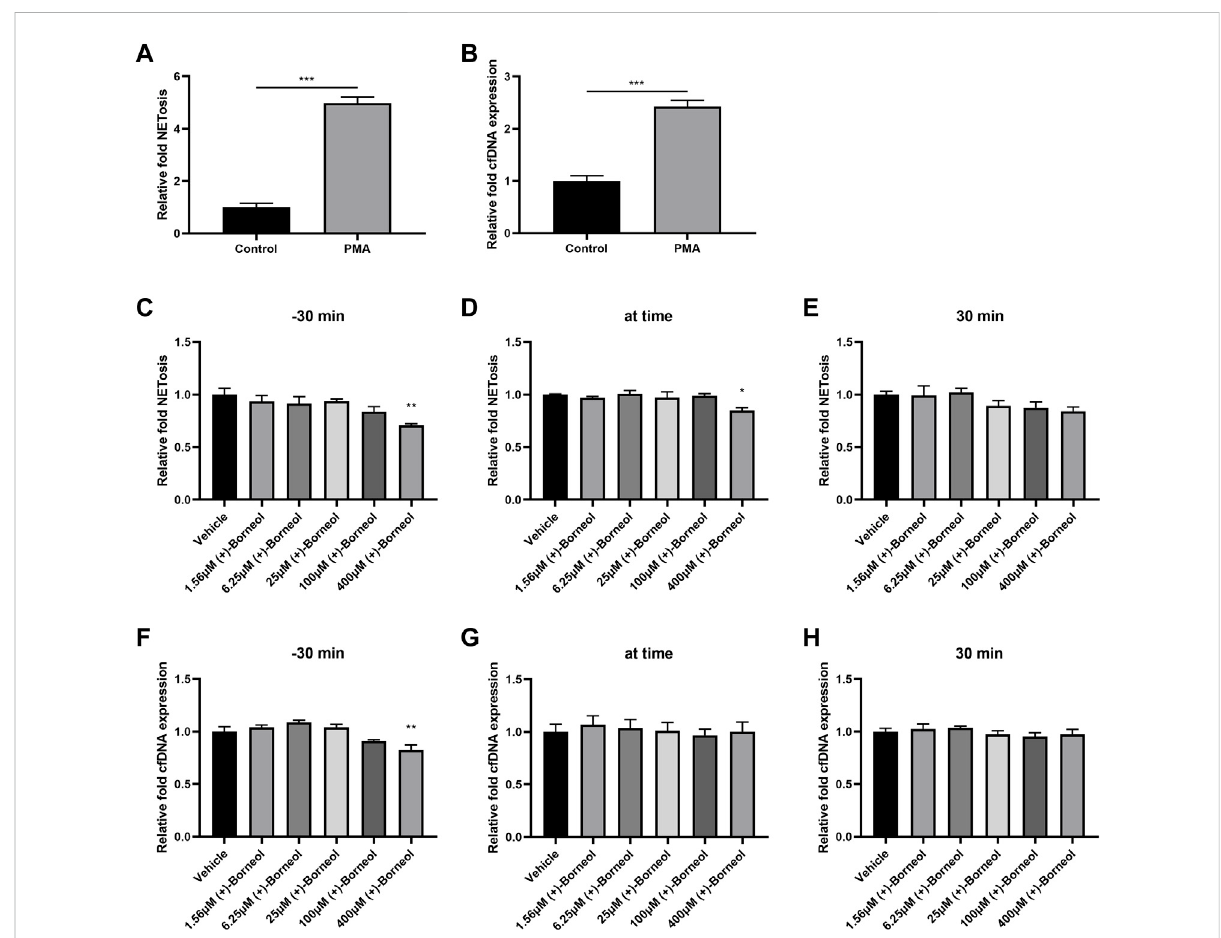
FIGURE 2 (+)-Borneol reduces PMA-induced NETosis. Neutrophils were stimulated with PMA for 4 h, (A) NETosis was measured by the NETosis assay kit, and (B) cfDNA was measured by the Quant-iT PicoGreen dsDNA Assay Kit. Neutrophils were treated with (+)-borneol (1.56, 6.25, 25, 100,